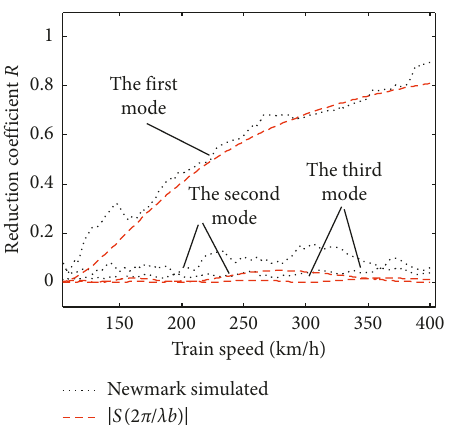
Figure 12: Reduction of bridge acceleration from spread load for the 1st mode to the 3rd mode (ML model).